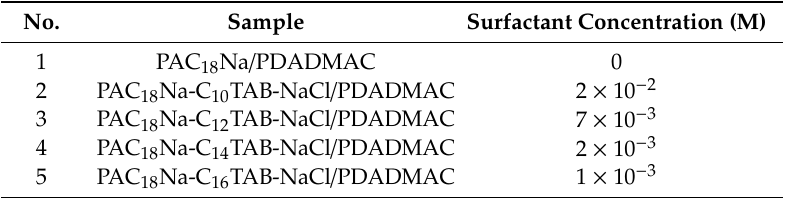
Table 1. Hydrophobicallymodifiedpoly(acrylate)–surfactantfilmsinvestigatedforantimicrobialproperties.